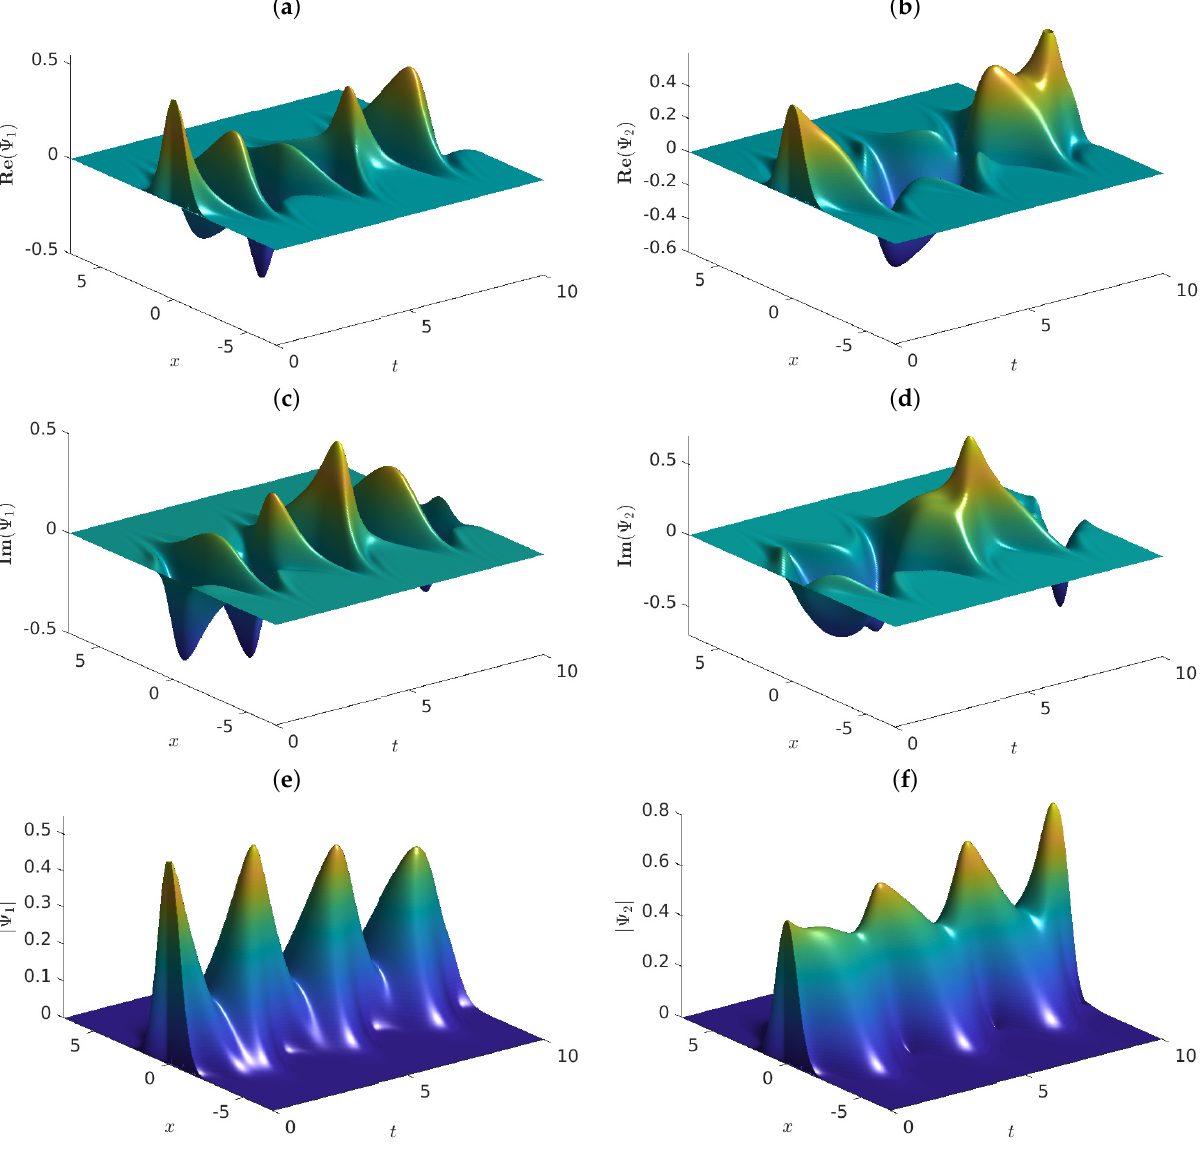
Figure 1. Graphs of the approximate solutions of problem (4) vs. ( x , t ) , employing α 1 = α 2 = 2, h 1 = 0.1 and τ = 0.01. The graphs show ( a ) Re Ψ 1 , ( b ) Re Ψ 2 , ( c ) Im Ψ 1 , ( d ) Im Ψ 2 , ( e ) | Ψ 1 | and ( f ) | Ψ 2 |